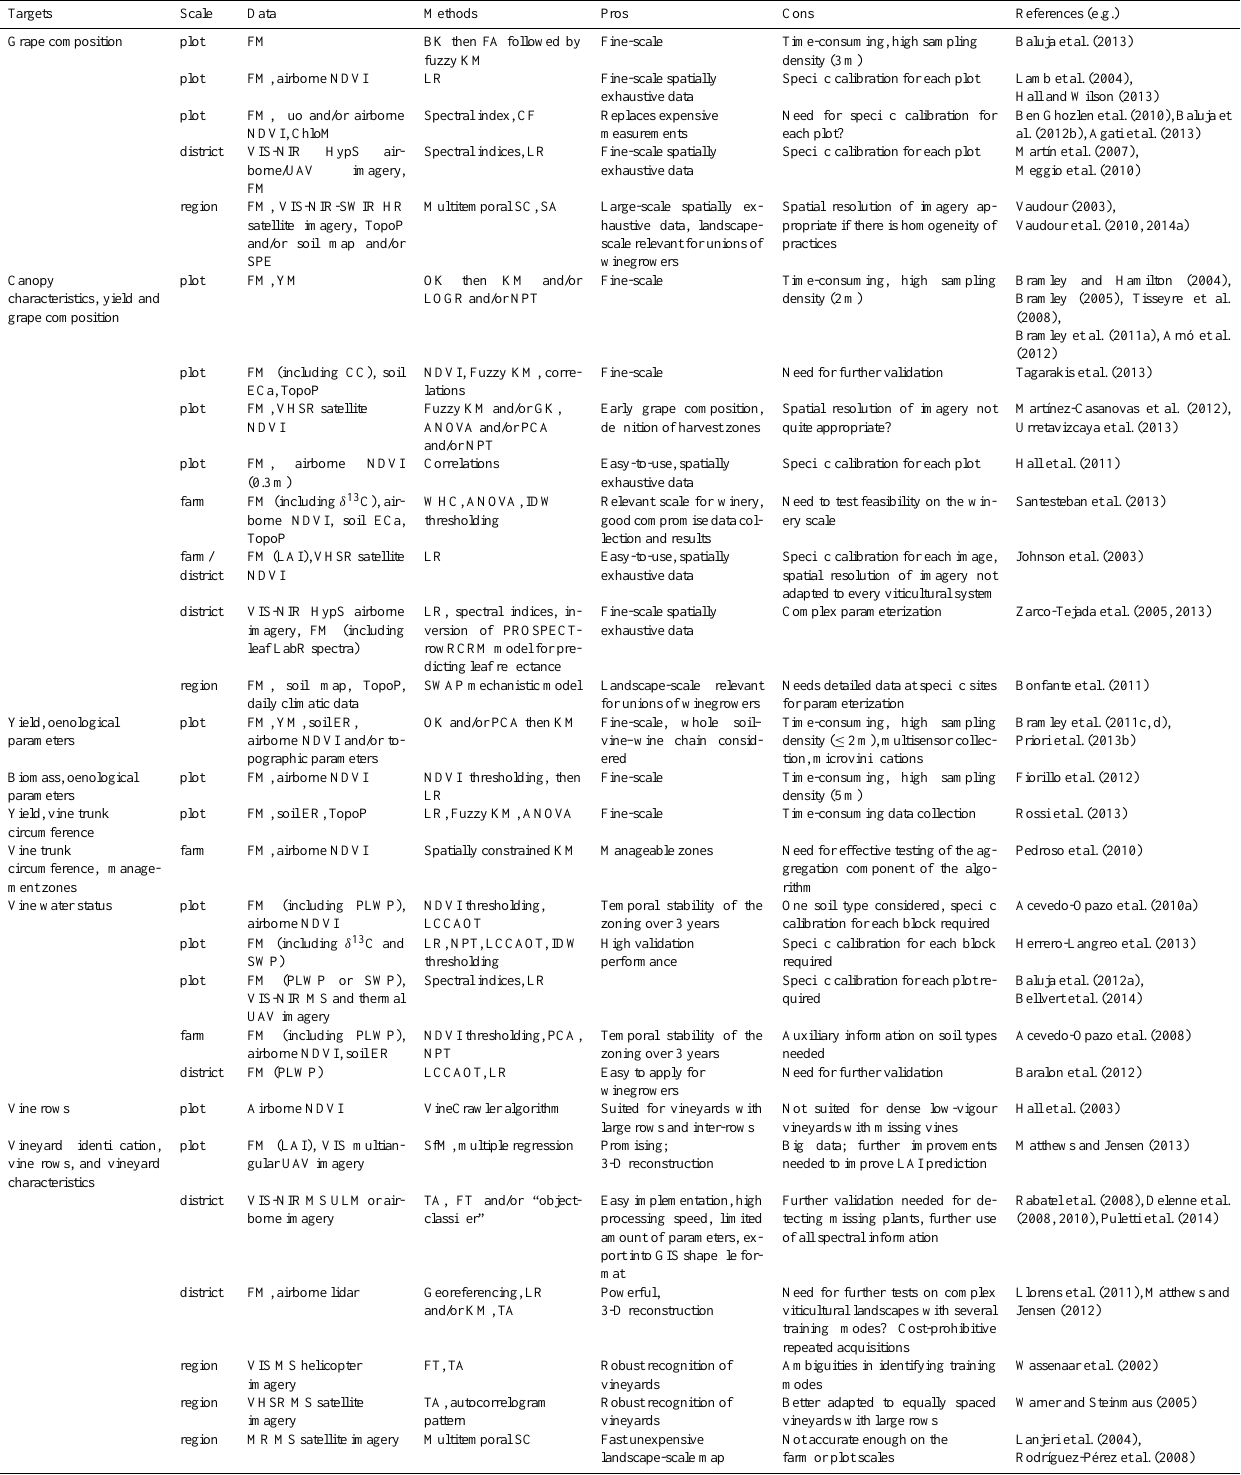
Table 2. Typology of zoning studies carried out over the 2002–2014